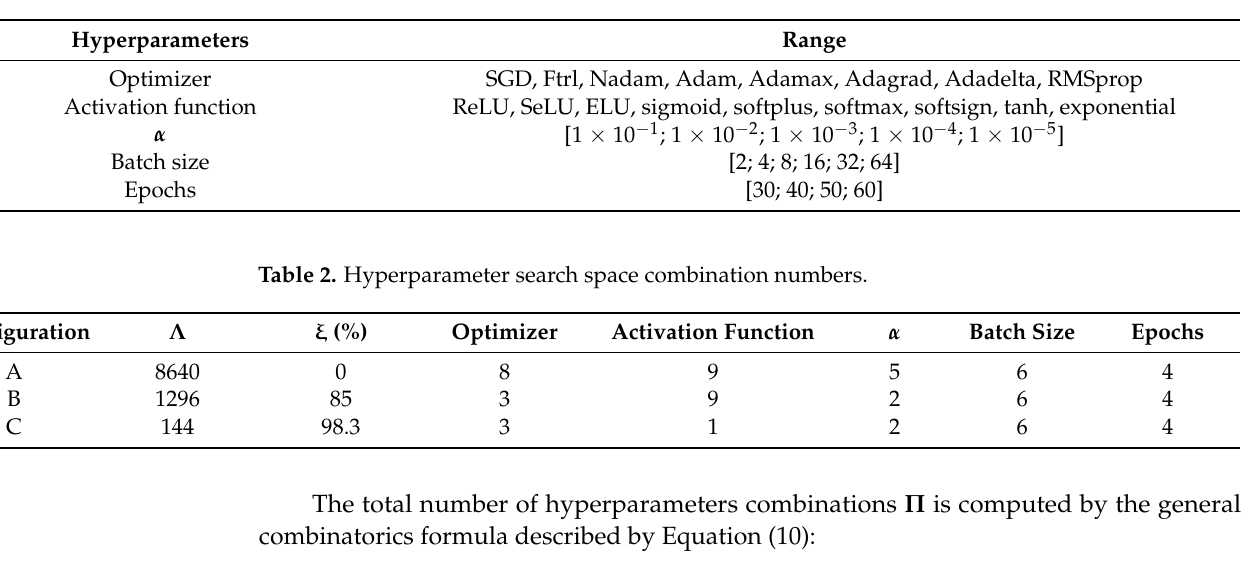
Table 1. Hyperparameter search space values (raw configuration A).